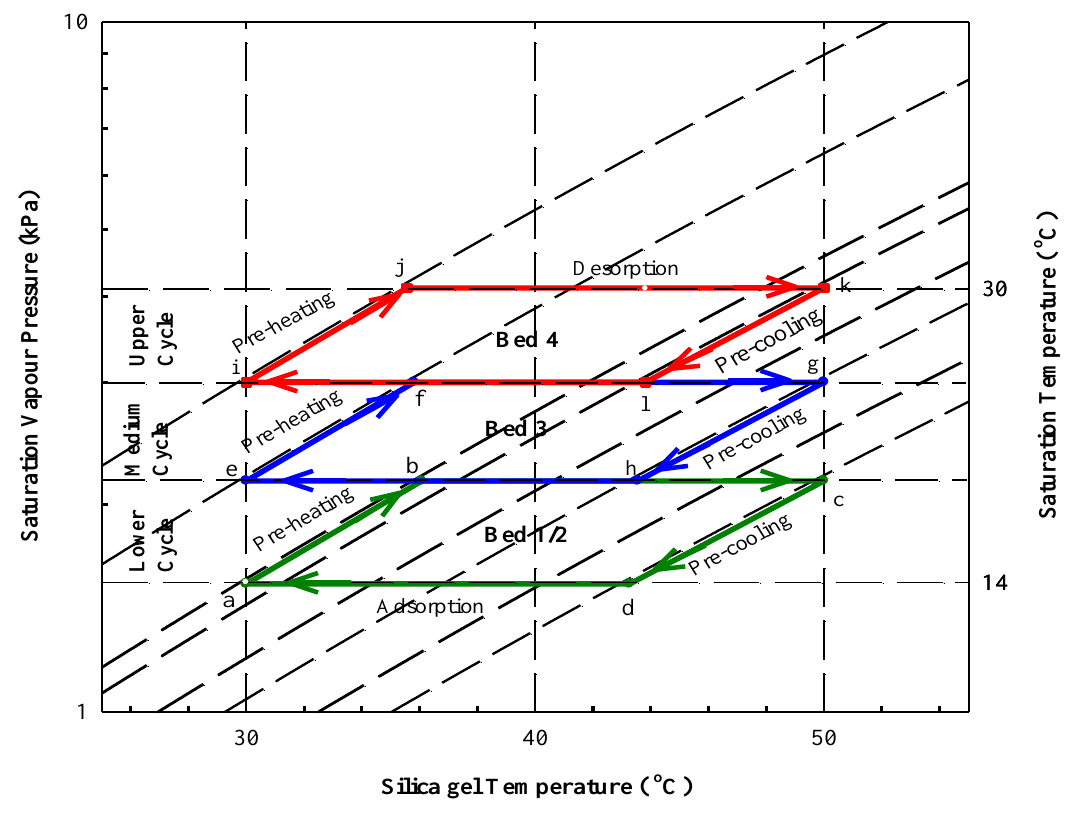
Figure 2. Conceptual Dühring diagram of the proposed